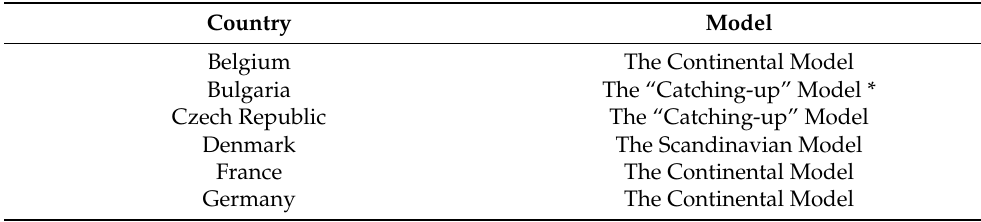
Table 2. Countries that have been data